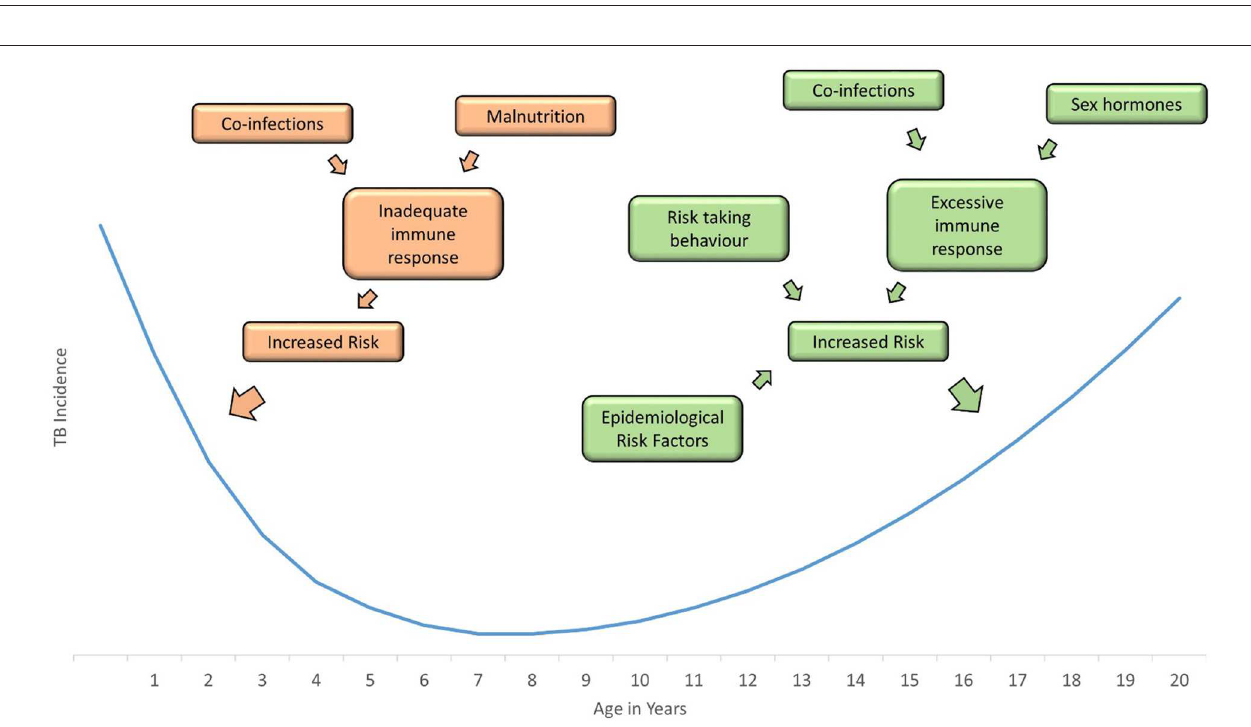
FIGURE 2 | Incidence of childhood tuberculosis is greatest in infants and adolescents; a number of factors increase the risk in these age groups, including co-infections, hormones, behavior, and epidemiological risk factors.